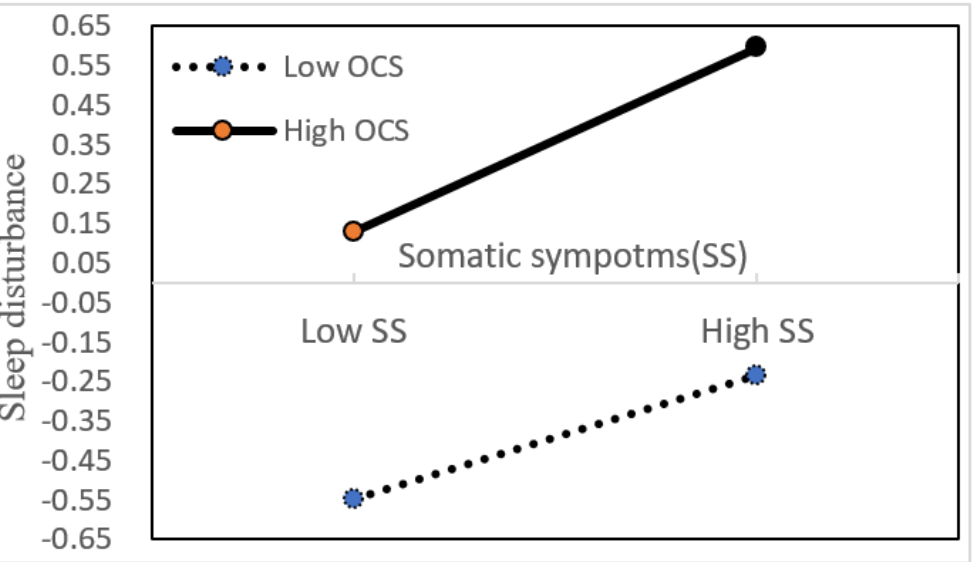
Figure 3. The moderating effect on relationship between somatic symptoms (SS) and sleep disturbance. Note: All variables in the model have received standardized treatment.